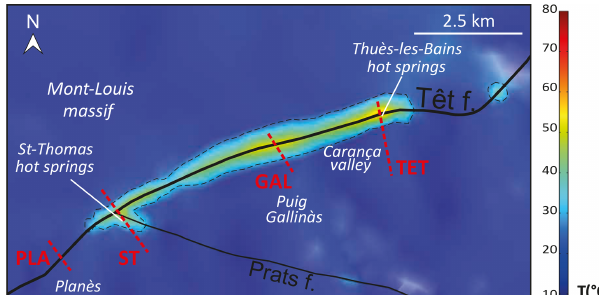
Figure 4. Map view of the modelled surface temperatures taking into account a permeability of 7.10 − 15 and 5.10 − 15 m 2 for the Têt fault zone and Prats fault zone (black lines), respectively. The dotted black lines correspond to the limit of the modelled surface temper- ature anomaly (modified after Taillefer et al., 2018). The four red dotted lines are sampling profiles (TET, GAL, ST, and